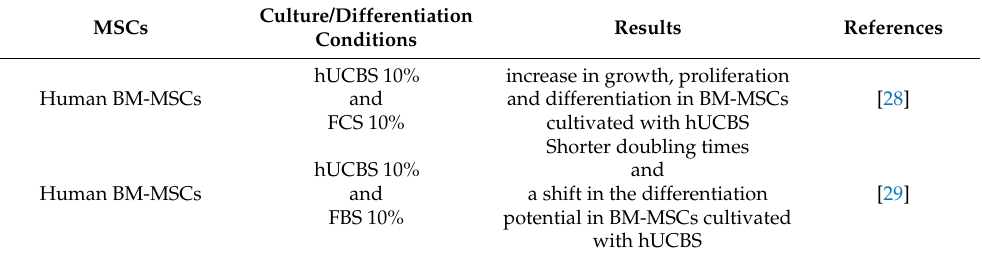
Table 2. Summary of the in vitro studies that reported the effects of human umbilical cord blood serum in MSCs